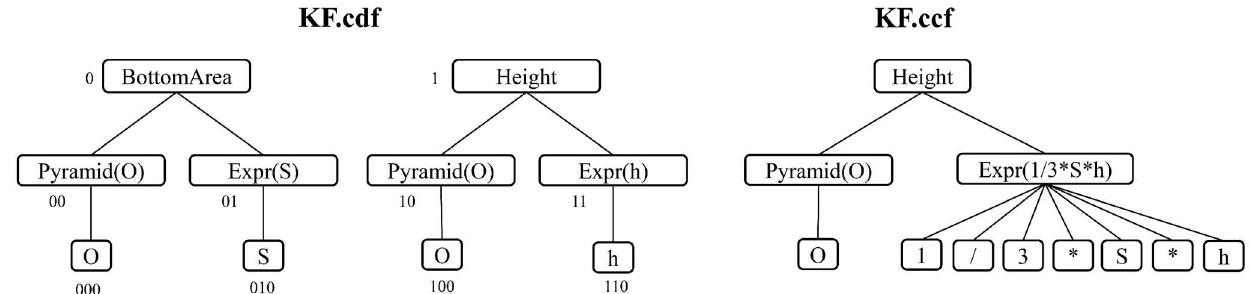
Figure 5. Rule knowledge forest.